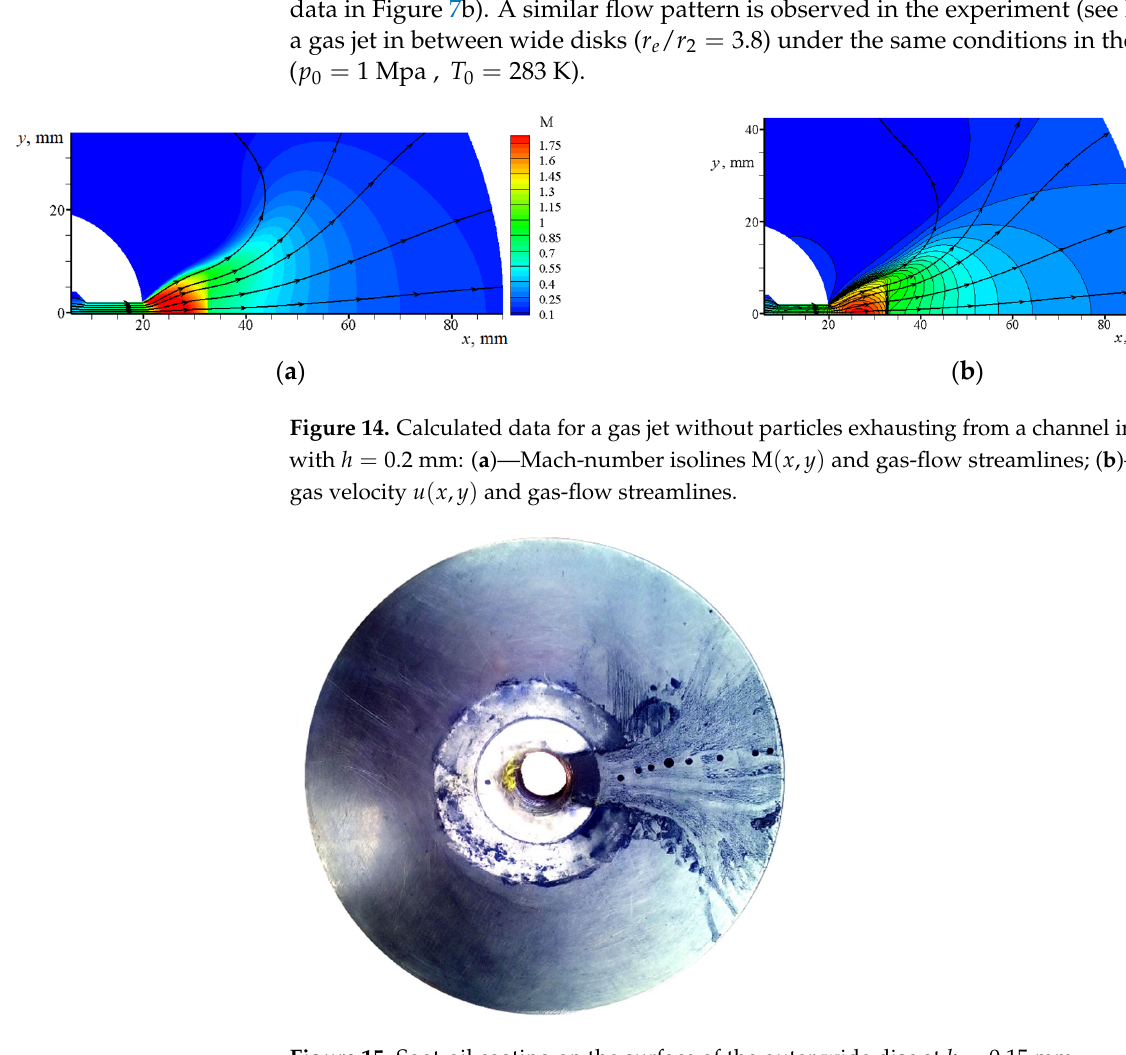
Figure 15. Soot-oil coating on the surface of the outer wide disc at h = 0.15 mm. Figure 15. Soot ‐ oil coating on the surface of the outer wide disc at . This difference between the flows in the slot space in between the narrow and wide disks is due to the different position of the shock wave in the two cases. In the case of the narrow disks, the shock wave is located at the end of the slot space (see Figures 5 and 8), so that the gas flow between the disks turns out to be supersonic for the most part. The expansion of the jet in this case occurs due to the rotation of the velocity vector in the centered rarefaction wave. In the case of wide disks (see Figures 13 and 14), the shock wave is located at the beginning of the slot space; that is why the gas flow behind the shock wave is subsonic in a larger region of the slot